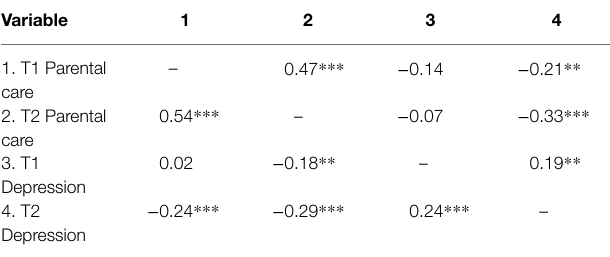
TABLE 3 | Bivariate correlations between study variables.